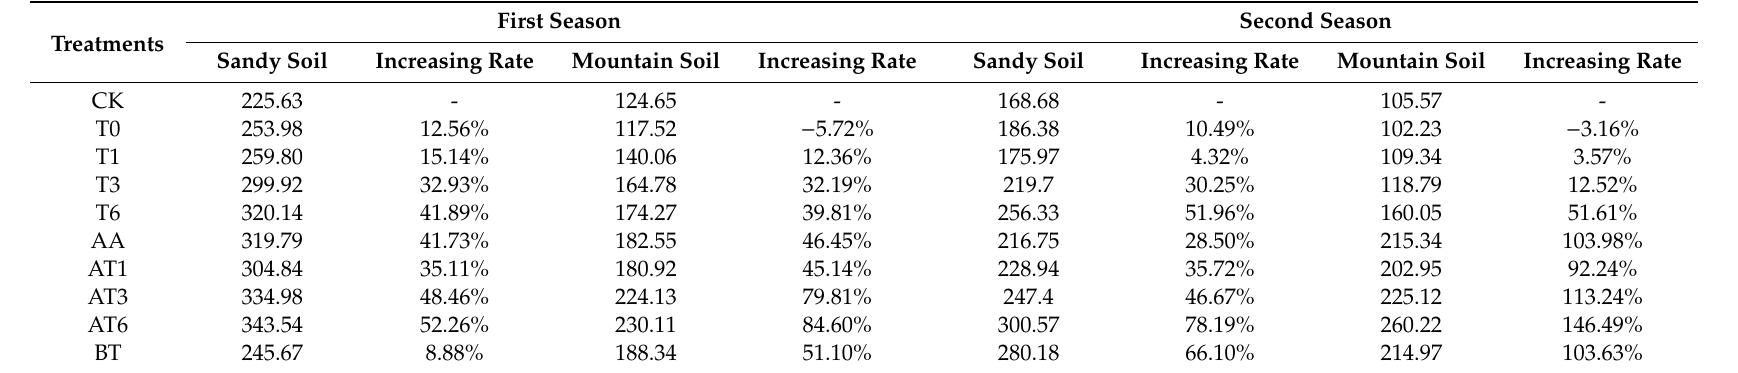
Table 2. The pepper yields of di ff erent treatments in two kinds of soil during two